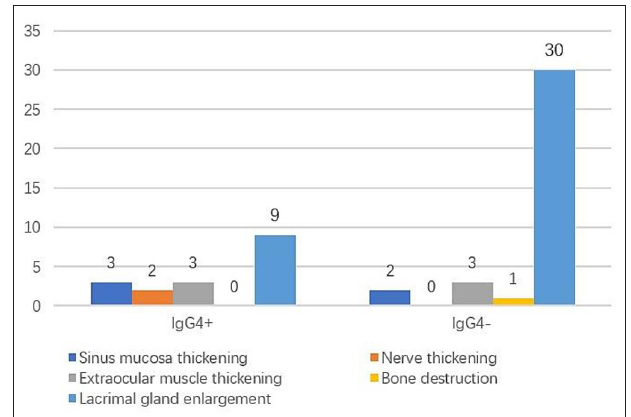
FIGURE 1 | Imaging findings of